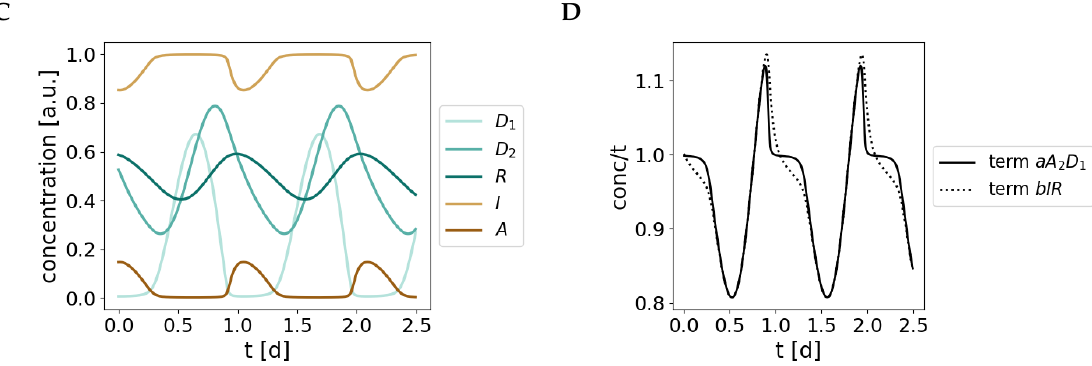
Figure A3. Reduced 4-ODE model for circadian redox oscillations. ( A ) The 6-ODE model is simplified to the 5-variable model shown in this figure. A represents Prx3-SOH; I , Prx3-SO 2 H; D 1 , mitochondrial H 2 O 2 ; D 2 , cytosolic H 2 O 2 ; and R , mitochondrial Srx. ( B ) Equations of the 5-variable model. We assume constant A + I over time and thus the number of ODEs is reduced to 4, with the dynamics of I being described by a mass conservation law. ( C ) Limit cycle oscillations obtained by numerical integration of the equations shown in ( B ) for the following parameter values (a.u.): a = 1000, b = 2, c = 10,000, d = 0.2, e = q = 0.1, p = 1. The period of oscillation is 24.5h; the phase shift between I and R is 8.8h. ( D ) Similar evolution of the bilinear terms bIR and aAD 1 over time for the parameter values in ( C ), allowing the quasi-steady state state approximation that leads to the simplified model shown in Figure